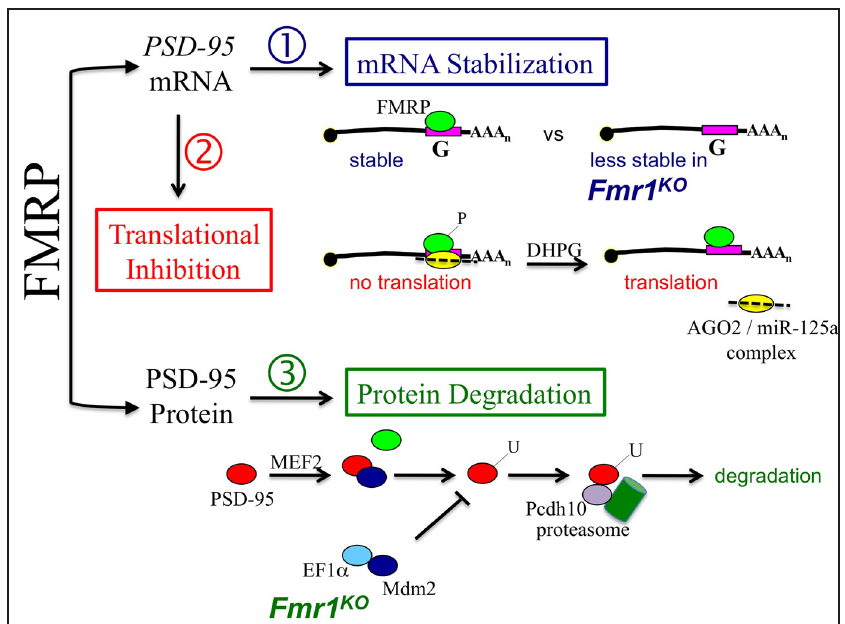
FIGURE 1 | Fragile X mental retardation protein (FMRP) poses a triple threat to postsynaptic density protein 95 (PSD-95) levels at the synapse. (1) FMRP binds directly to a guanine (G)-rich sequence within the 3’-untranslated region (UTR) of PSD-95 mRNA to regulate mRNA stability (Zalfa et al., 2010). (2) Phosphorylated FMRP recruits Argonaute 2 (AGO2) and microRNA-125a (miR-125a) into an inhibitory complex on PSD-95 mRNA that blocks translation (Muddashetty et al., 2012). Group 1 mGluR stimulation with ( S )-3,5-dihydroxyphenylglycine (DHPG) leads to dephosphorylation of FMRP, release of AGO2 from the mRNA and activation of translation. And (3) myocyte enhancer factor 2 (MEF2) induces ubiquitination of PSD-95 by the E3 ligase murine double minute 2 (Mdm2), which allows for the association of PSD-95 with protocadherin 10 (Pcdh10) and proteasomes. The degradation of PSD-95 by proteasomes leads to synaptic pruning (Tsai et al., 2012). However, in the absence of FMRP, elongation factor 1 alpha (EF1 α ) is overexpressed and sequesters Mdm2 resulting in decreased ubiquitination (U) and degradation of PSD-95. It remains to be determined how the multiple functions of FMRP are coordinated in a cell- and/or brain region-specific manner to control synpatic levels of